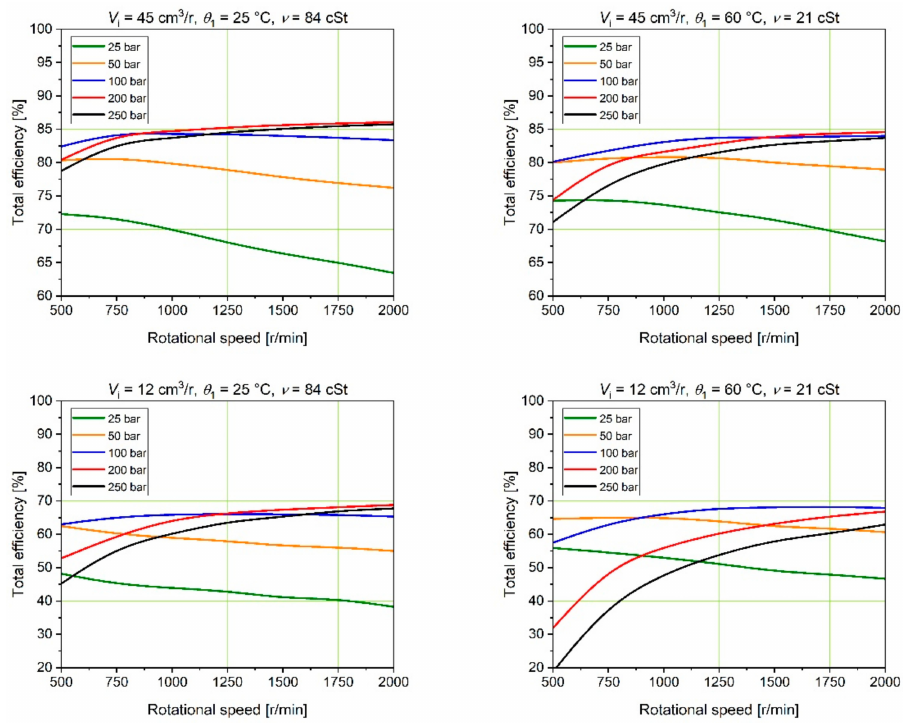
Figure 10. Total efficiency of an axial piston pump as a function of rotational speed with five constant pressures. The seven-calculation-point efficiency curves have been smoothed with B-splines. Note the varying efficiency